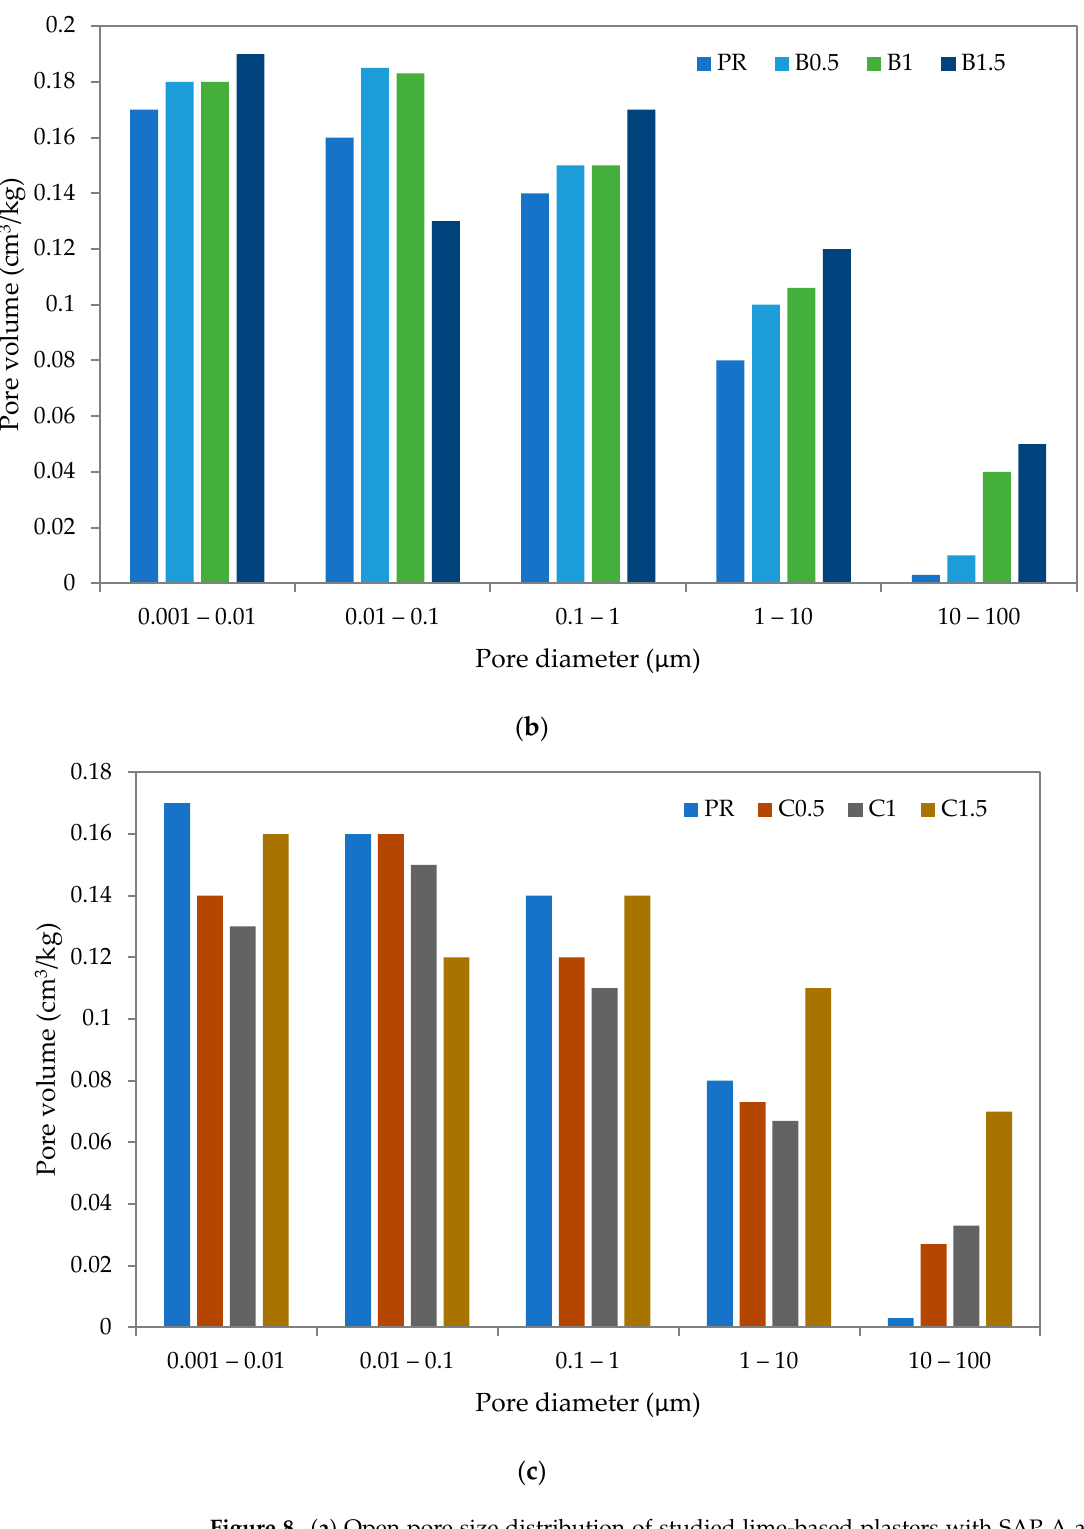
Figure 8. ( a ) Open pore size distribution of studied lime-based plasters with SAP A admixtures; ( b ) open pore size distribution of studied lime-based plasters with SAP B admixtures; ( c ) open pore size distribution of studied lime-based plasters with SAP C admixtures.